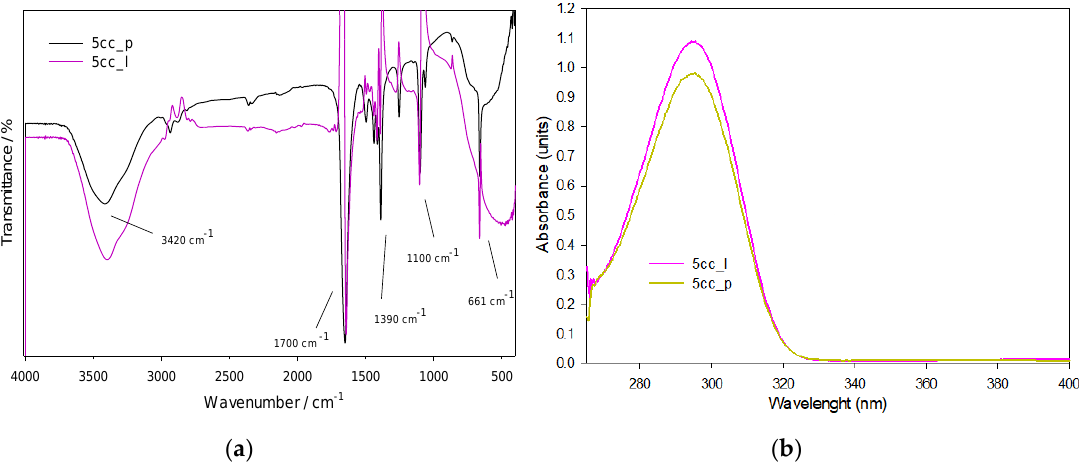
Figure 5. ( a ) FTIR spectrum and ( b ) UV-Vis spectrum of both phases of 5cc. Table 2. FTIR bands of cyclic carbonates as identified elsewhere